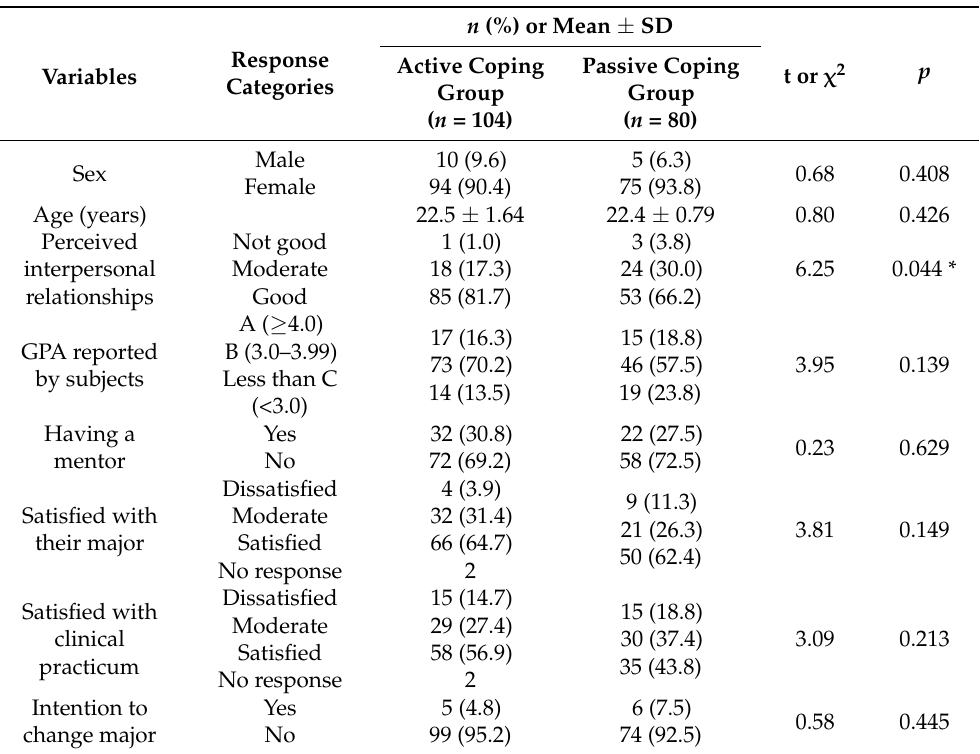
Table 1. General characteristics of nursing students that had completed their initial practicum ( n =